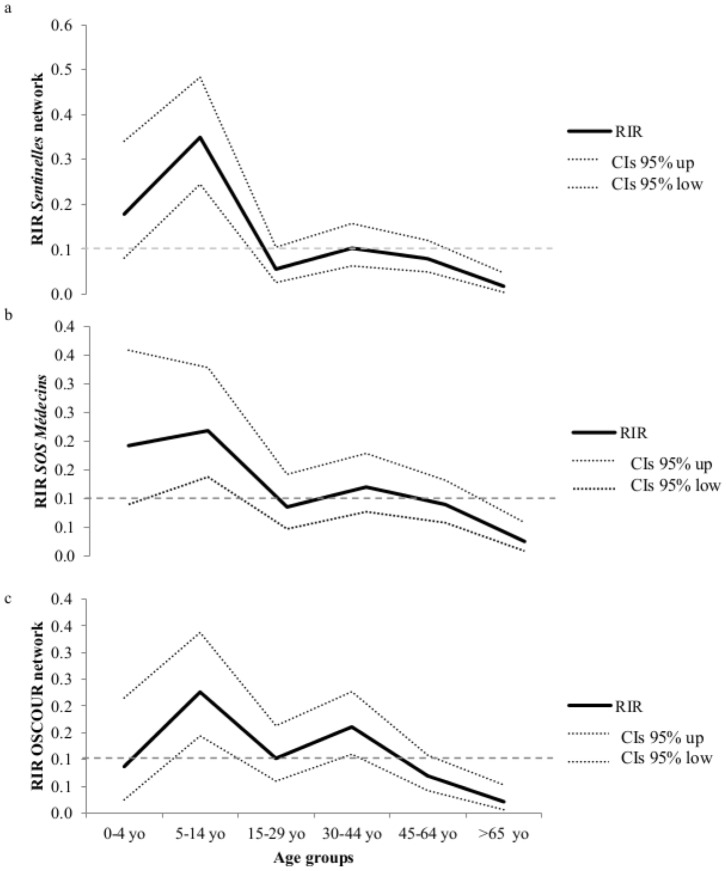
Relative Illness Ratio (RIR) by age-group for the 2012–2013 epidemic (black line) and 95% confidence intervals (CIs) (dotted line) by surveillance ILI network: (a) Corsican Sentinelles network; (b) SOS Médecins and (c) OSCOUR network.